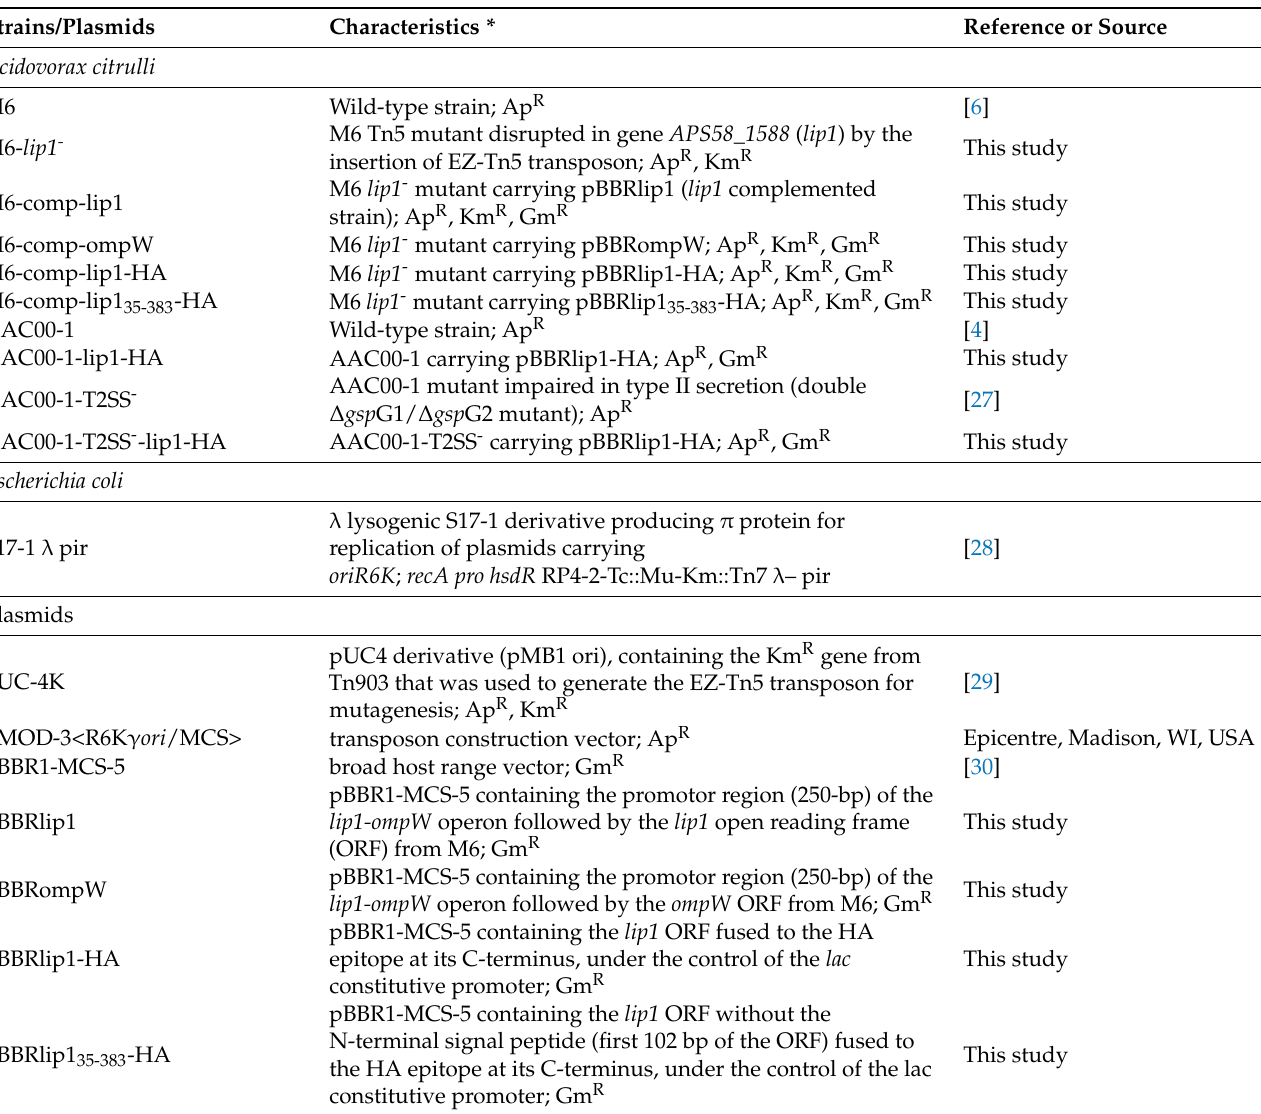
Table 1. Strains and plasmids used in this